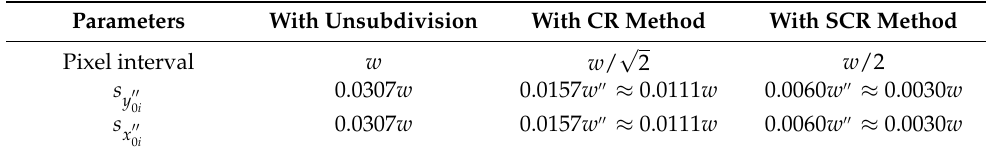
Table 2. Two standard deviations of ring centre coordinates with or without subdivision ( i best =